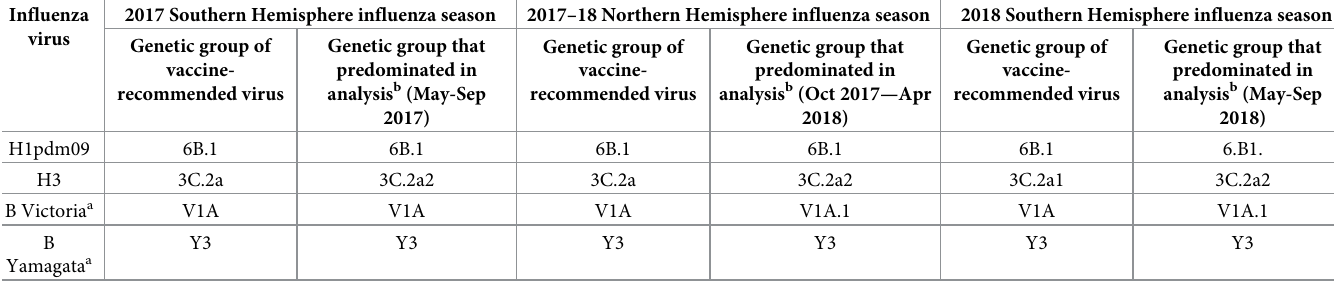
Table 3. Predominant genetic groups of circulating viruses compared to influenza vaccine-recommended